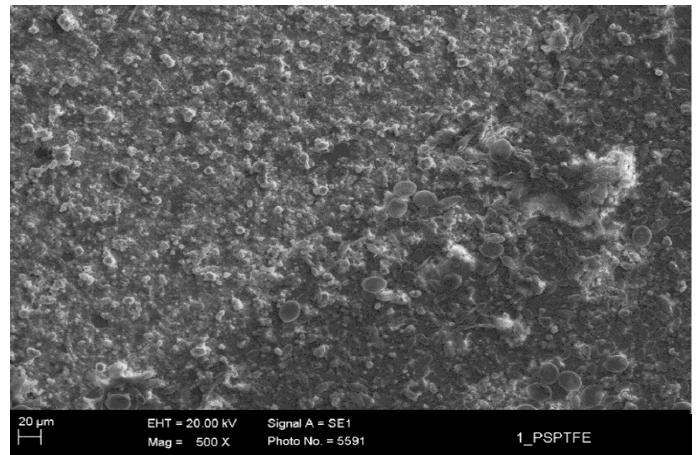
Figure 9. Scanning electron microscopy (SEM) image at 500× of recycled polymer coating in a zone at the border of the bubble; the left-upper side of the image was under the bubble.